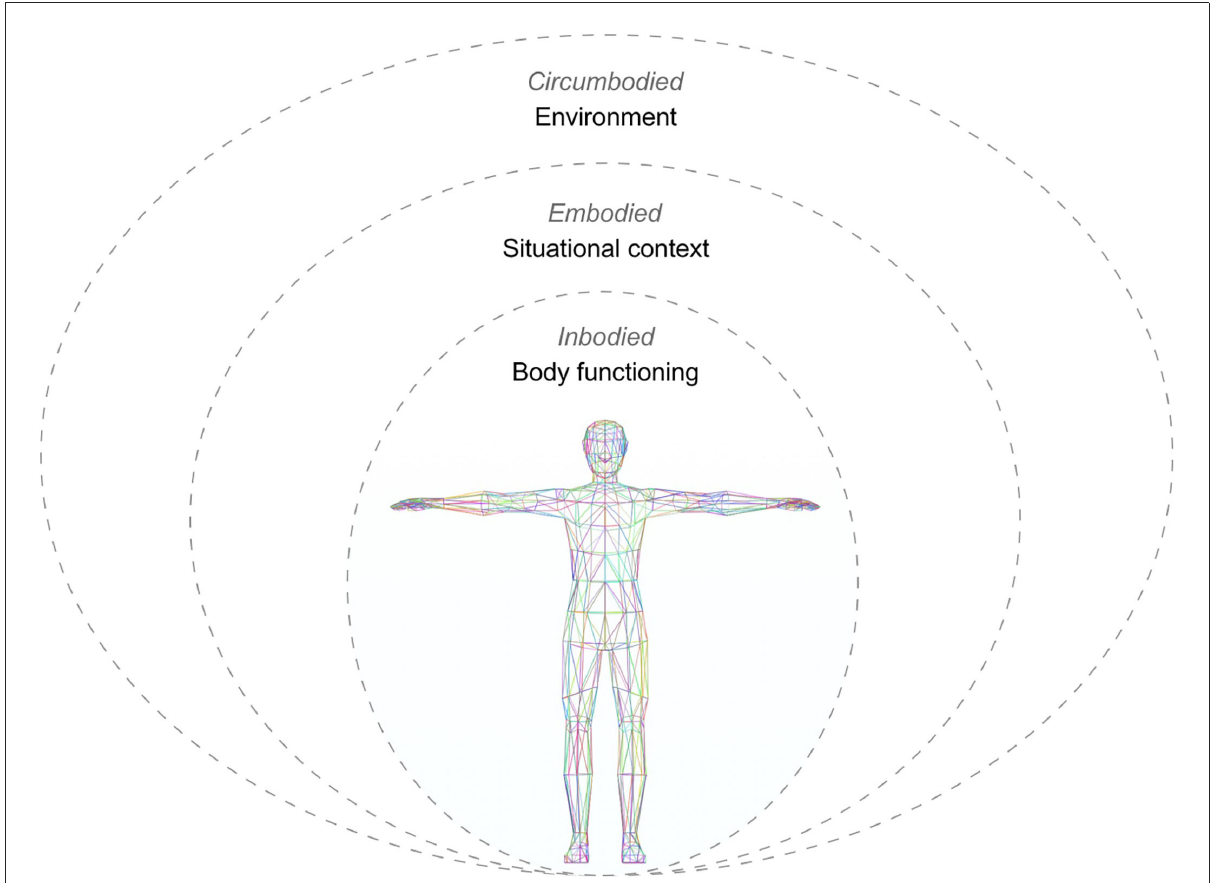
FIGURE1 The in-, em-, and circum-bodied as interdependent systems to reflect on technology interventions and their effects on